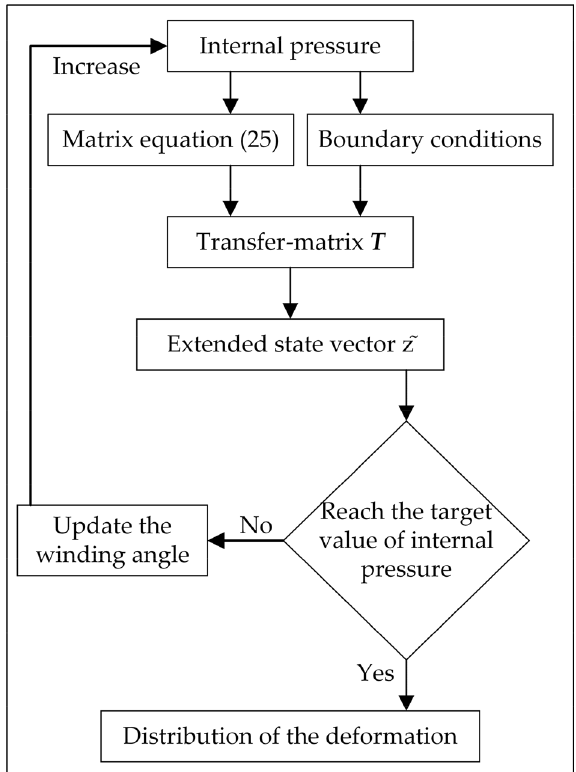
Figure 3. The approach of deformation calculation of fialment-wound hyperbolic flexible pipes.